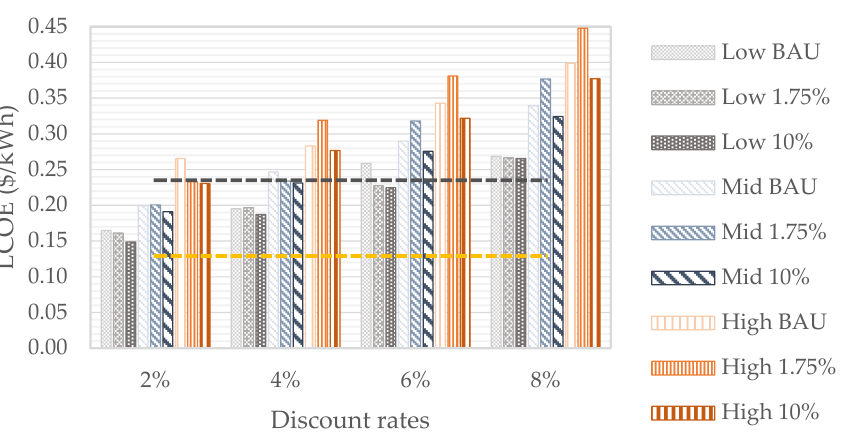
Figure 10. The sensitivity results for Anonymous with 45 ◦ tilt angle, different discount rate, varying components costs, and varying average load with and without energy efficiency considerations. The yellow dot line indicates commercial rate.